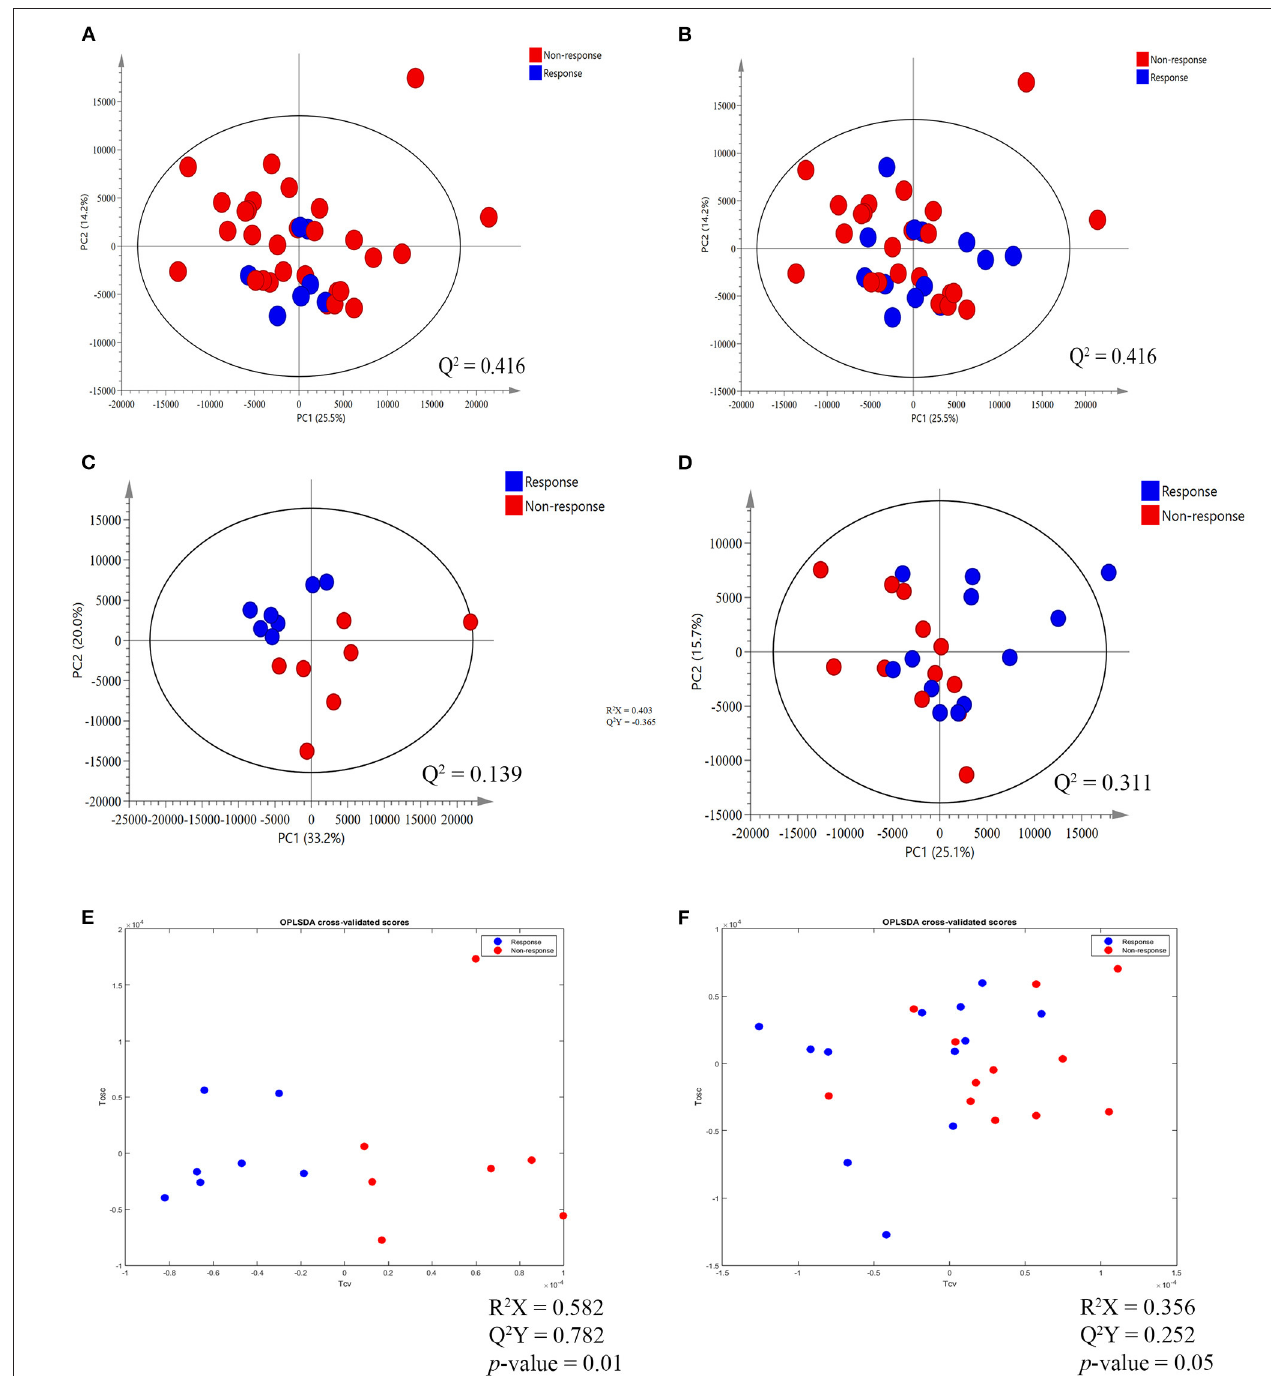
FIGURE 1 | Principal component analysis (PCA) score plot and orthogonal partial-least square discriminant analysis (O-PLS-DA) cross validated score plot between response and non-response to gemcitabine and cisplatin in tumor tissues of patients with cholangiocarcinoma (CCA). (A,B) The PCA score plot between response and non-response group to gemcitabine and cisplatin, respectively, before match the meta-data of patients with CCA. (C,D) The PCA score plot, after match the meta-data of patients with CCA, between response and non-response group to gemcitabine and cisplatin, respectively. (E,F) The O-PLS-DA cross validated score plot between the response and non-response group to gemcitabine and cisplatin, respectively. The data were Pareto scaled.